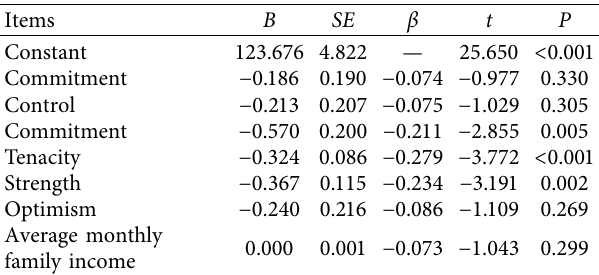
Table 6: Multiple linear regression of factors influencing the guardian’s sense of disease uncertainty in children with IBD analysis